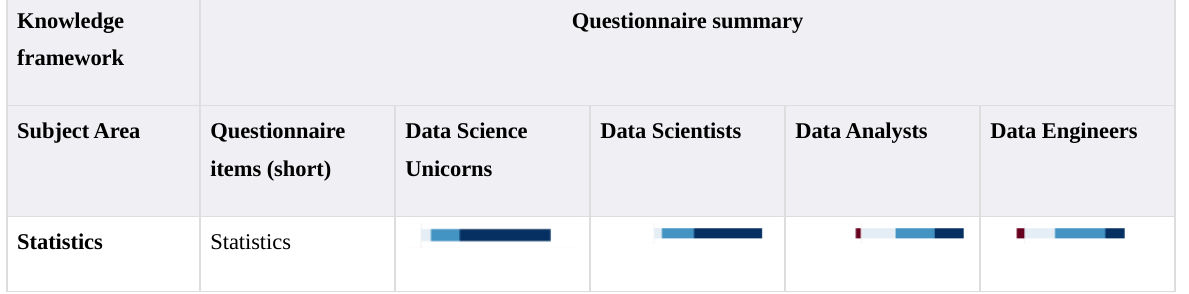
Table 7. Summary of the questionnaire.